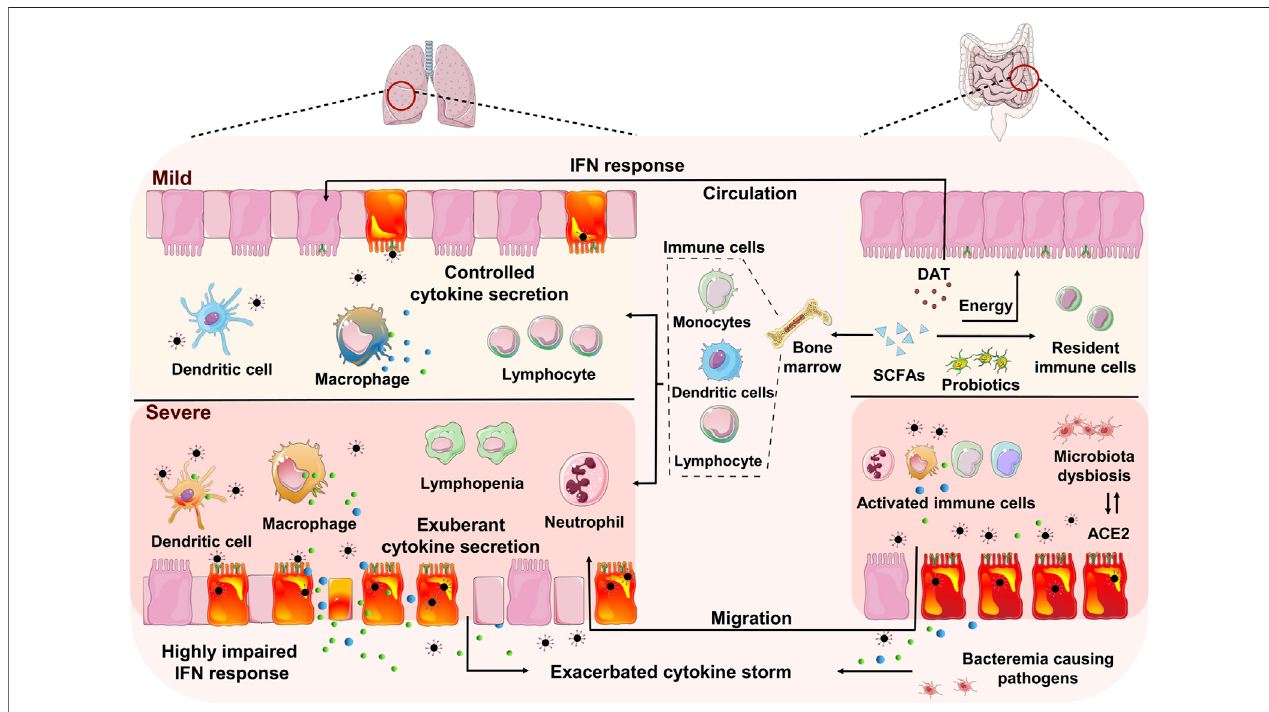
FIGURE 1 | Schematic model of the gut-lung interaction in mild and severe COVID-19. The pulmonary immune responses in mild case were characterized by low numbers of in fi ltrating neutrophil and proin fl ammatory macrophages, along with a controlled level of proin fl ammatory cytokine secretion. While the predominant pulmonary immunopathology in severe COVID-19 is associated with signi fi cantly impaired interferon (IFN) responses, increased in fi ltration of neutrophils and proin fl ammatory macrophages, impaired antigen-presenting cells, reduction and functional exhaustion of cytotoxic T lymphocytes and exacerbated cytokine secretion. The intestine and lung communication enables traf fi cking of the immune cells and microbial metabolites along the gut-lung axis. The bene fi cial commensal bacteria and microbial metabolites, including short-chain fatty acids (SCFAs) and desaminotyrosine (DAT), may promote the antiviral innate immune responses and alleviatetheimmunopathogenicactivities.Whereasthedisordersofintestinalmicroecologymaycontributetothepulmonarydiseasedeteriorationviabacteremiaandthe enrichment and spreading of the proin fl ammatory immune responses, in which the infected gut may be one of the origins of cytokine